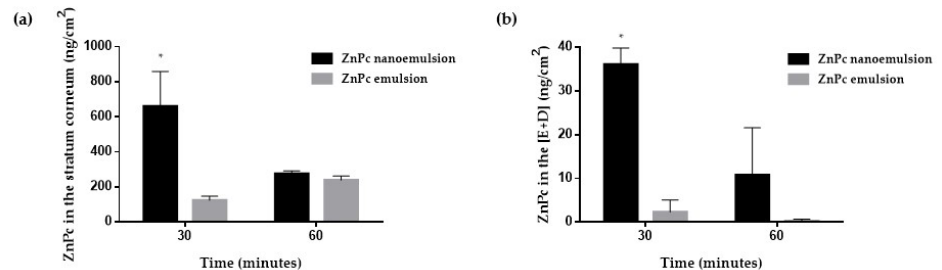
Figure 7. Iontophoresis in vitro: ZnPc recovered from ( a ) stratum corneum and ( b ) viable skin (E + D) after iontophoretic treatment of skin with ZnPc nanoemulsion (black columns) and emulsion (gray columns). * significant statistical difference (ANOVA with Tukey’s post hoc test, p < 0.05).